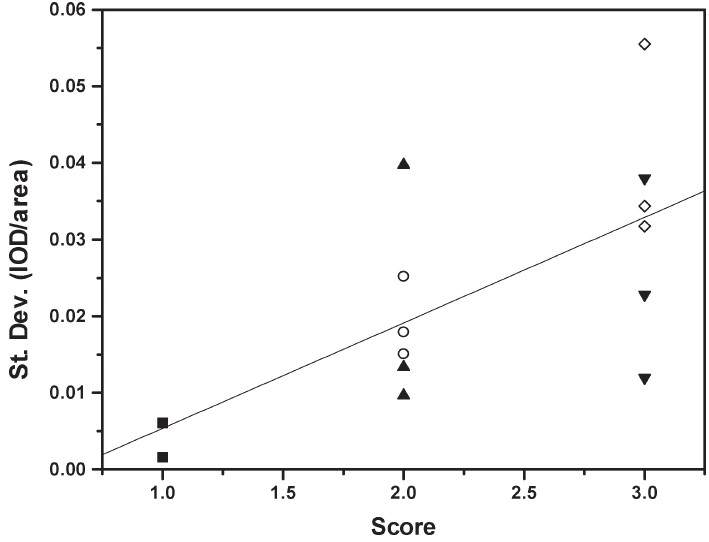
Fig. 6. Relationship between standard deviation of IOD/area and pathologist score for bcl -2 protein expression for the same regions shown in Fig. 4. A line is drawn through the slide mean